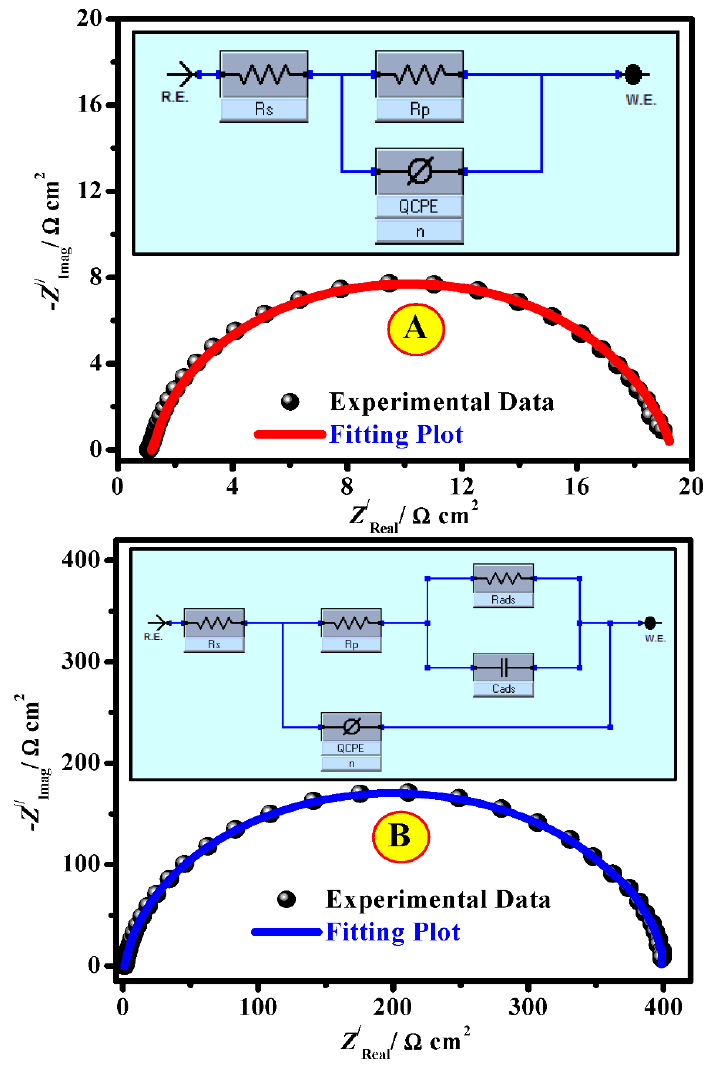
Figure 10. Comparison of empirical Nyquist results (points) and fitted data (line) measured the SS316 alloy in the absence ( A ) and the existence of 200 ppm NCC ( B ). Inset equivalent circuit for the corrosion performance of investigated systems’ ( A ) uninhibited medium and ( B ) inhibited medium. Table 2. EIS parameters obtained for SS316 alloy in 2.0 M HCl solution in the lack (blank) and existence of different concentrations of CEL and NCC at 50 ◦ C. Inhibitor